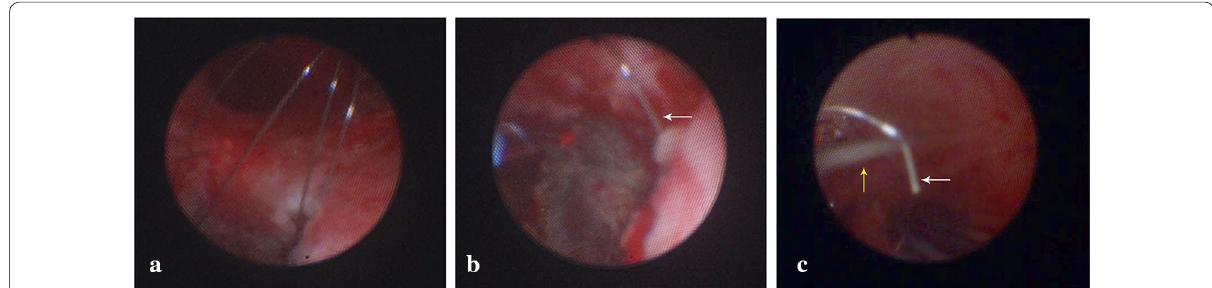
Fig. 1 a Distal broken part of basket. b Calculus fragmentation by laser with distal broken part of basket visible nearby (pointed by white arrow). c . Locating the broken tip of the distal fragment (pointed by white arrow) and grasping with another basket (pointed by yellow arrow) after stone clearance